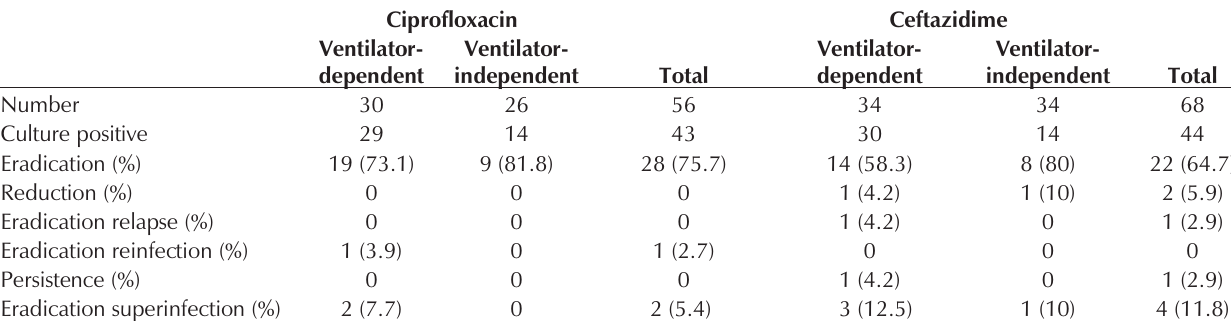
Bacterological response: End of therapy